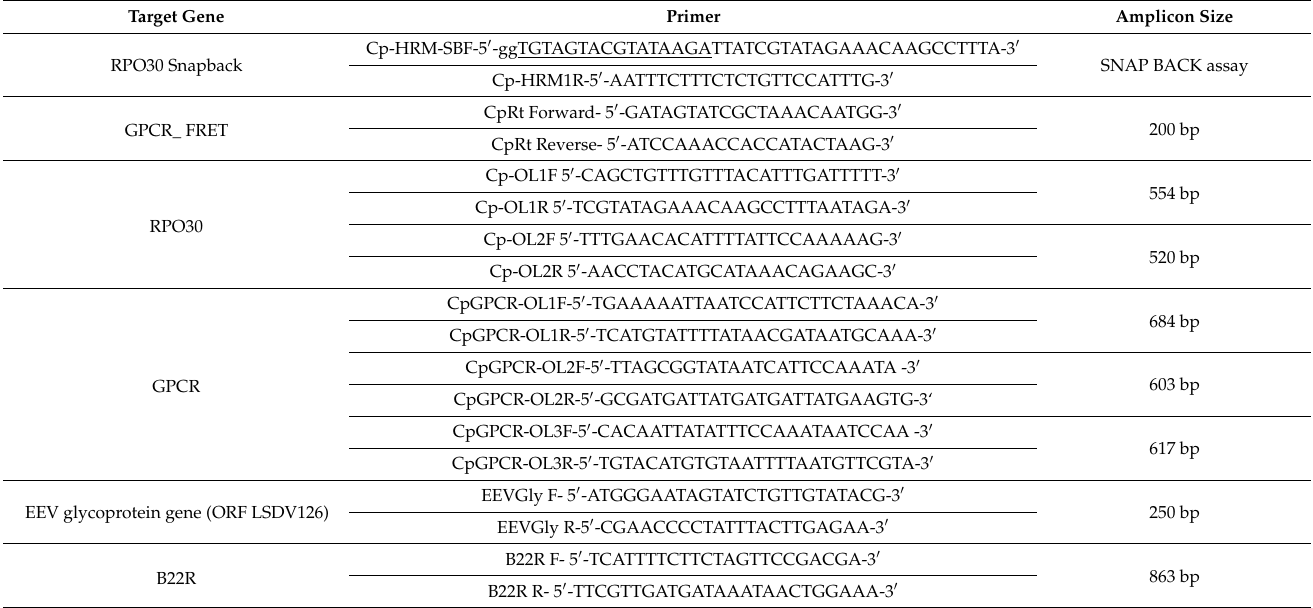
Table 2. List of the primers used for Snapback assay and amplification and sequencing of the targeted genes. The snapback tail of 16 bases is shown as